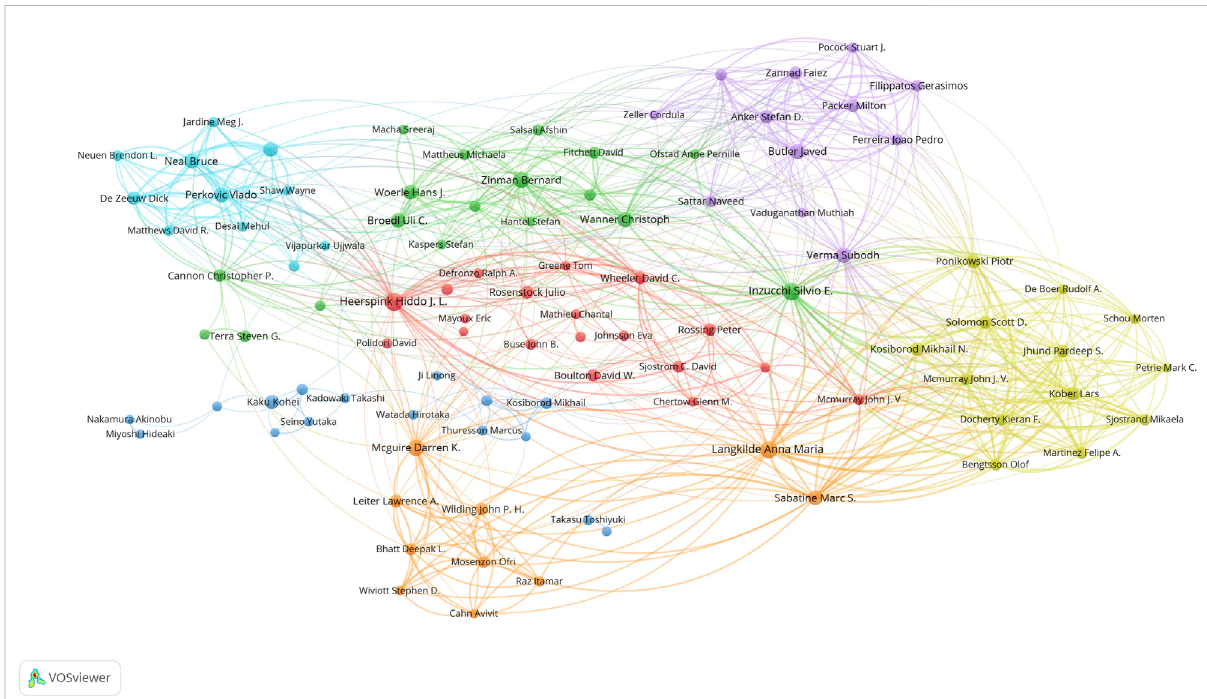
FIGURE 5 VOSviewer network visualization map of authors involved in SGLT2 inhibitor research. Collaboration analysis of the top 100 authors. Node size represents the co-authorship frequency, and the line between two nodes represents a collaboration between the two authors; the thicker the line, the closer the